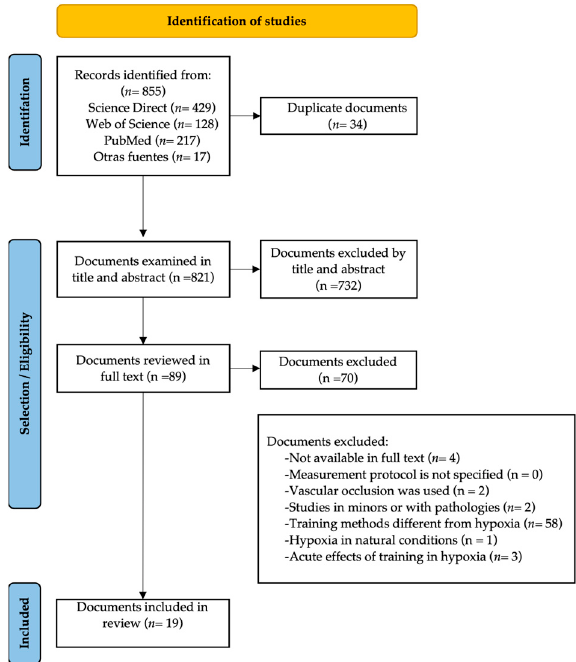
Figure 1. Flow diagram of the identification, selection, and discrimination of